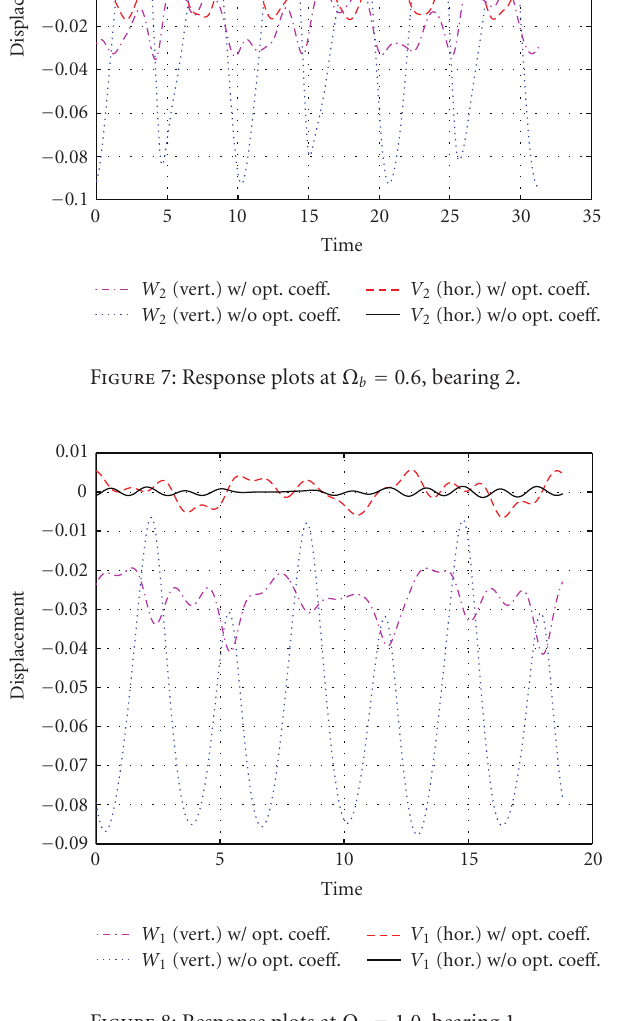
Figure 6: Response plots at Ω b = 0 . 1, bearing 1.